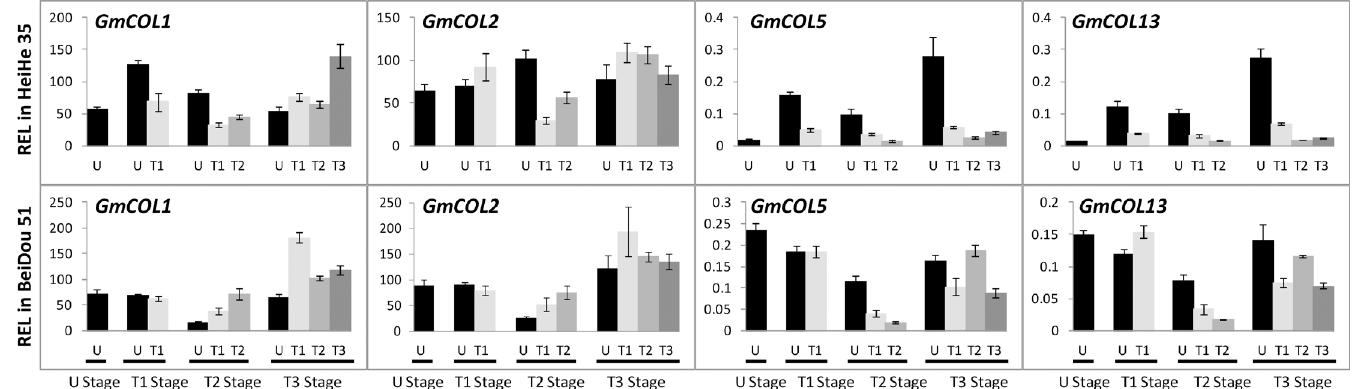
Fig 7. Relative expression level analyses of GmCOL s in different leaves in cultivars Heihe 35 and Beidou 51 at different stages. Relative expression levels (REL) were analyzed by RT-qPCR and normalized to UKN1 . Averages and standard errors are the result of three replicates. For detailed information on stages and sampling, see Materials and Methods section.